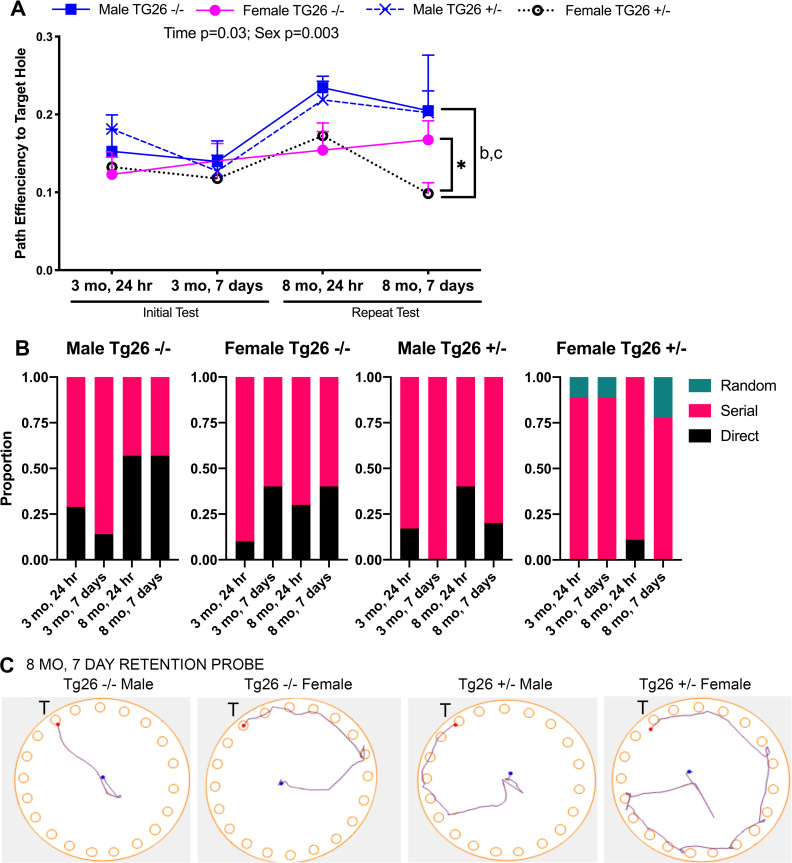
Barnes maze target hole path efficiency.Assessment of memory abilities on a Barnes maze during target hole analyses at 3 and 8 months of age, at two retention probe test points. (A) Mean path efficiency to the target hole, in which the lower number is a lower efficiency, as assayed by the AnyMaze software. Mean ± SEM shown. *: p<0.05, compared to wild type -/- mice of same sex; a<0.05, compared to values obtained for these same animals at the other time points indicated; b: p<0.05, compared to opposite sex of same genotype (opposite sex); c: p<0.05, compared to opposite sex of opposite genotype (opposite sex and genotype). (B) The strategies used by the mice at each testing time was manually scored as direct, serial or random, and is presented as a proportion per group. (C) Figures showing representative path efficiency plots from the 8 month, 7 day, retention probe. T = Target hole. Numbers/group as indicated in Fig 6.